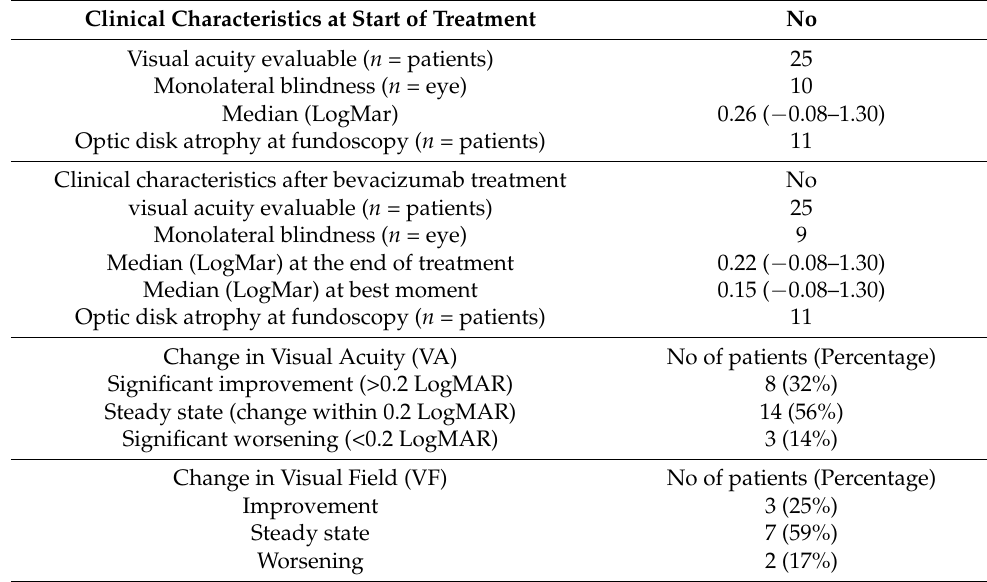
Table 3. Baseline ophthalmologic data and change in function after